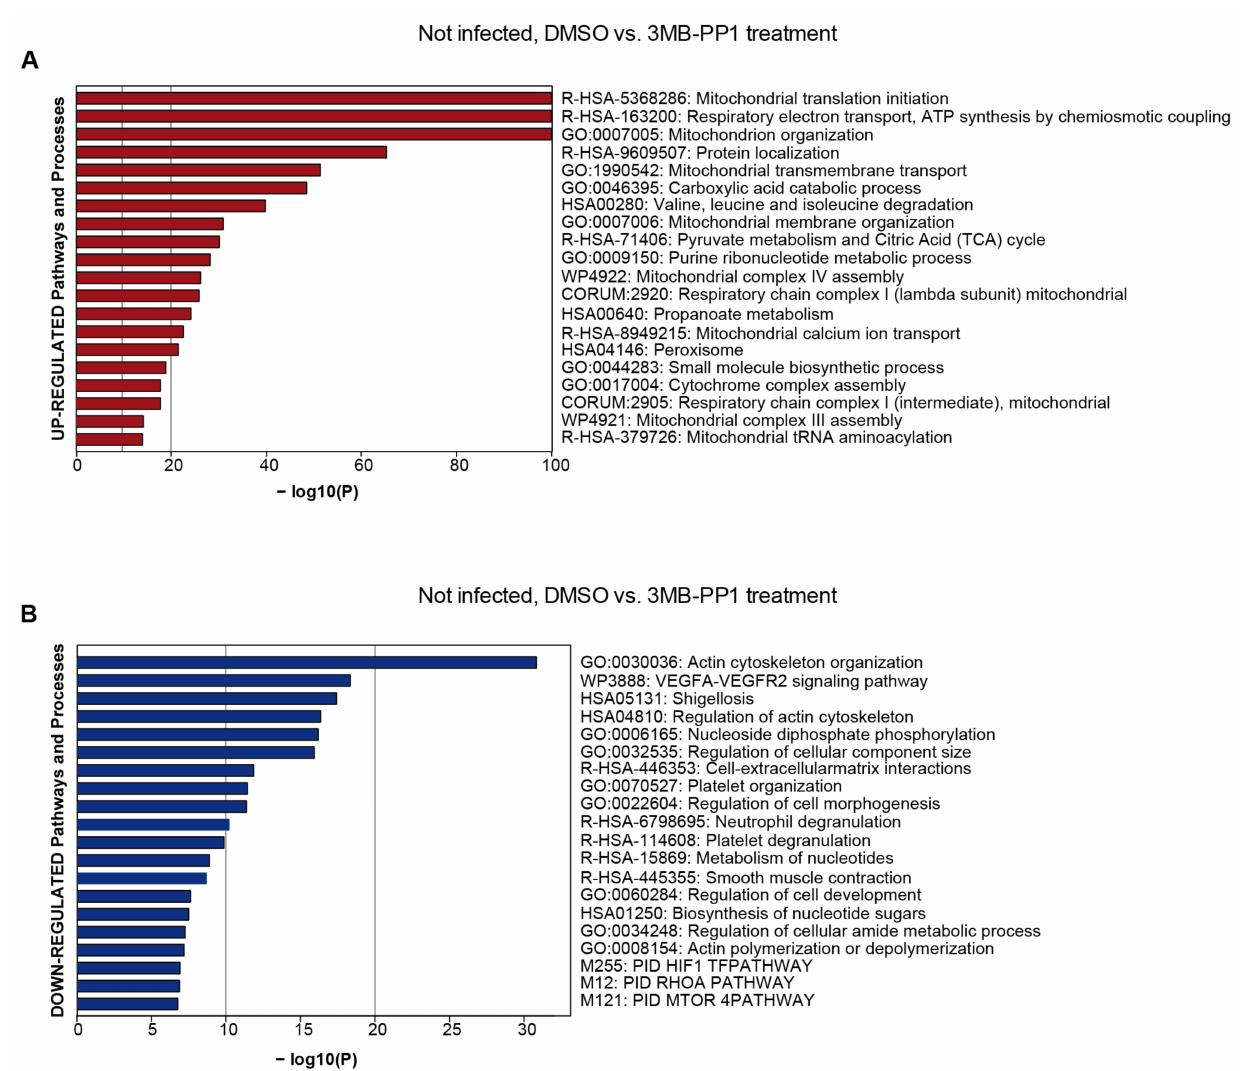
Figure 6. Dysregulated protein groups after 3MB-PP1 treatment in uninfected HFF. Pathway and process enrichment analysis of proteins up-regulated after 3MB-PP1 treatment (log2 ≥ 0.7 and p -value ≤ 0.05) ( A ). The top 20 clusters with their representative enriched terms are plotted according to their p -value in log base 10 (Log10 (P)). Enrichment analysis was performed with Metascape [30]. Pathway and process enrichment analysis of proteins down-regulated after 3MB-PP1 treatment (log2 ≤ − 0.7 and p -value ≤ 0.05) ( B ). The top 20 clusters with their representative enriched terms are plotted according to their p -value in log base 10 (Log10 (P)). Enrichment analysis was performed with Metascape [30]. Pathway results are shown with the number of proteins found in the dataset and computed FDR for pathway enrichment (FDR <